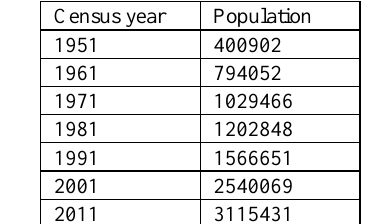
Source: Census of India Table 1. Population of Pune